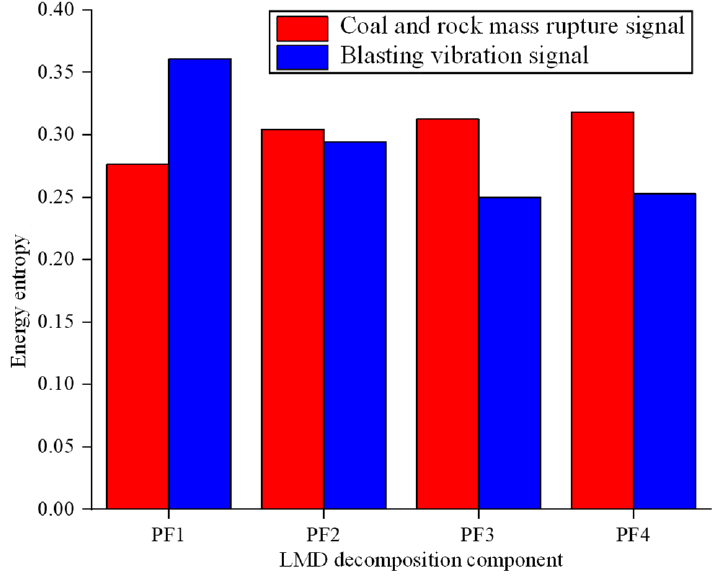
Figure 8. Energy-entropy-comparison diagram of typical microseismic signals in mines.